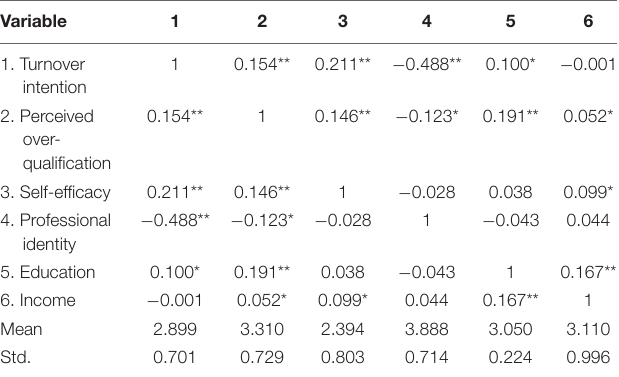
TABLE 3 | Means, standard deviations, and correlations.